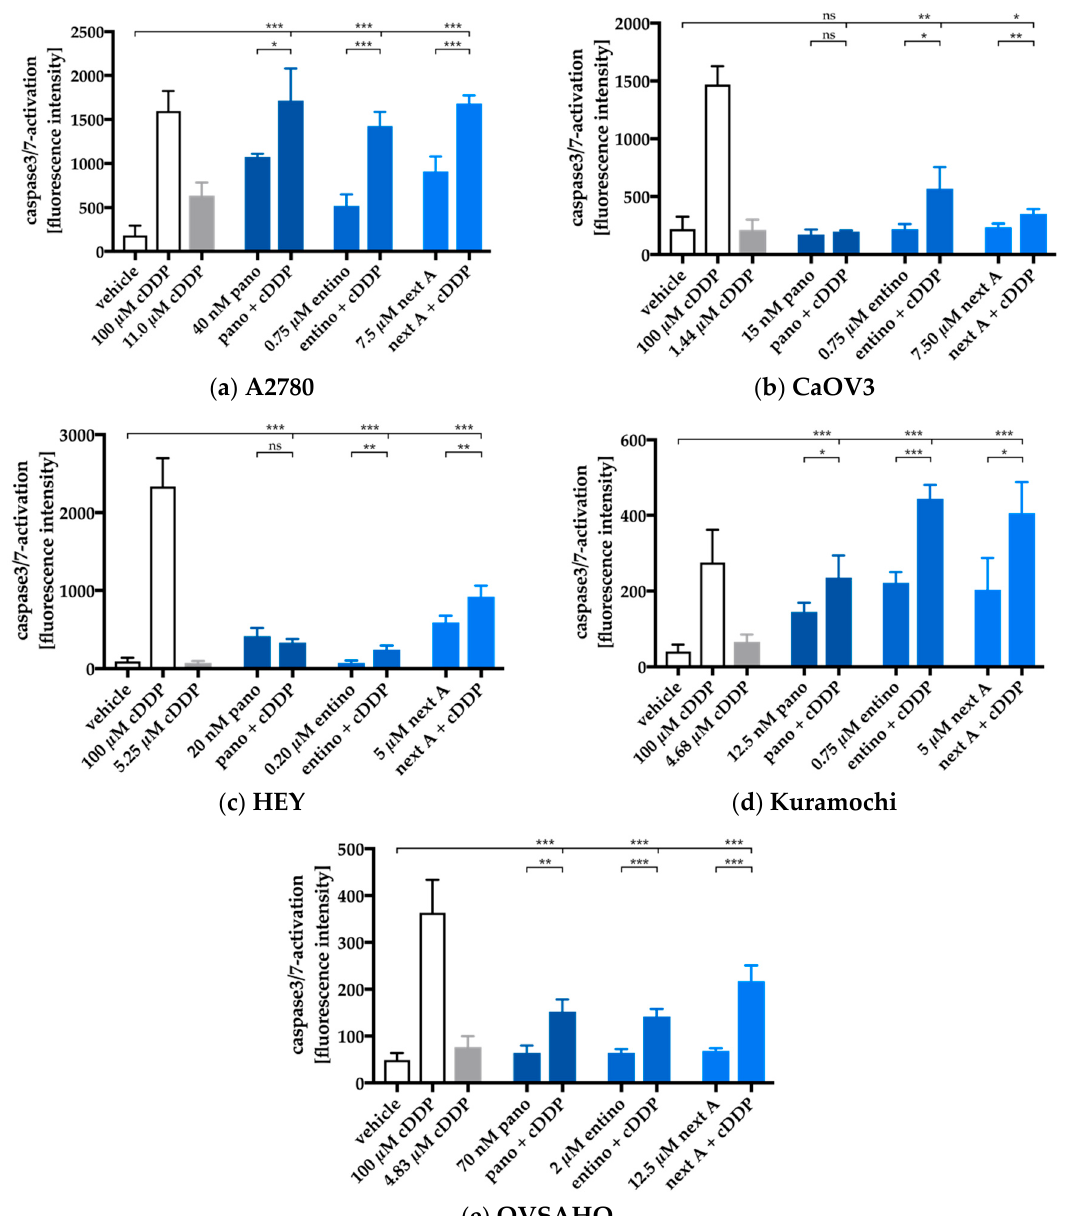
Figure 7. A2780 ( a ), CaOV3 ( b ), HEY ( c ), Kuramochi ( d ), and OVSAHO ( e ) cells were preincubated with HDACi for 48 h. Cisplatin was added in an IC 50 concentration for each cell line for a further incubation period of 24 h. Caspase3/7-activation was analyzed by incubation with CellEvent Caspase-3/7 green detection reagent (Thermo Scientific, Germany) and visualized by ArrayScan XTI. Cisplatin 100 µM (24 h) was added as positive control for caspase3/7-activation. 0.2% DMSO was added as a control for vehicle treated cells. All experimental conditions were incubated for same time periods.